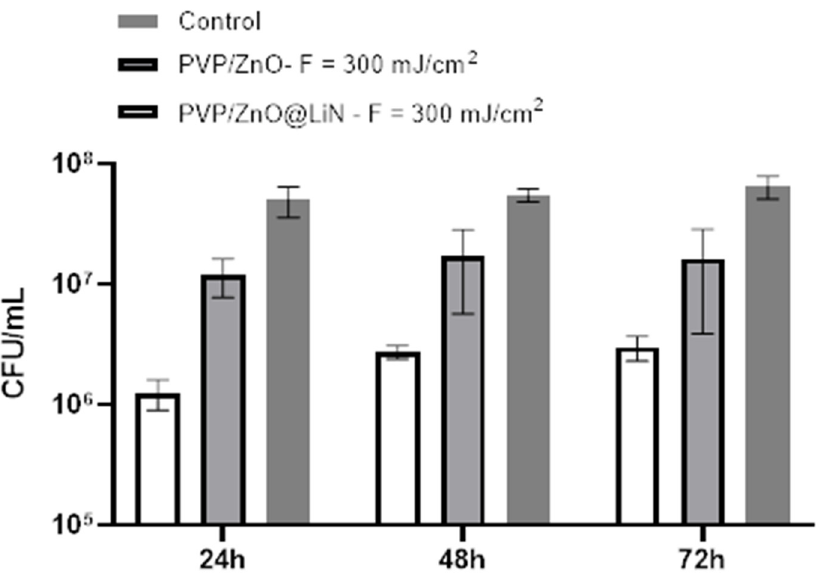
Figure 18. Evaluation of microbial biofilm development at 24, 48, and 72 h after incubation with E. coli in the presence and absence of PVP/ZnO@LiN